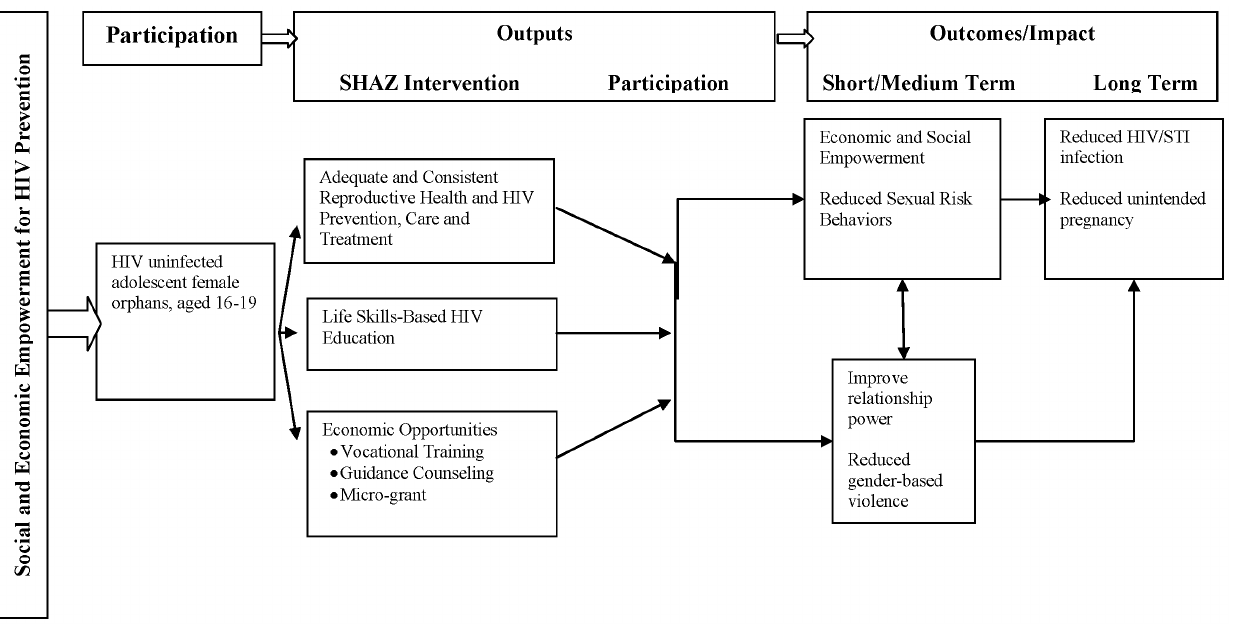
Figure 1. SHAZ! Theoretical